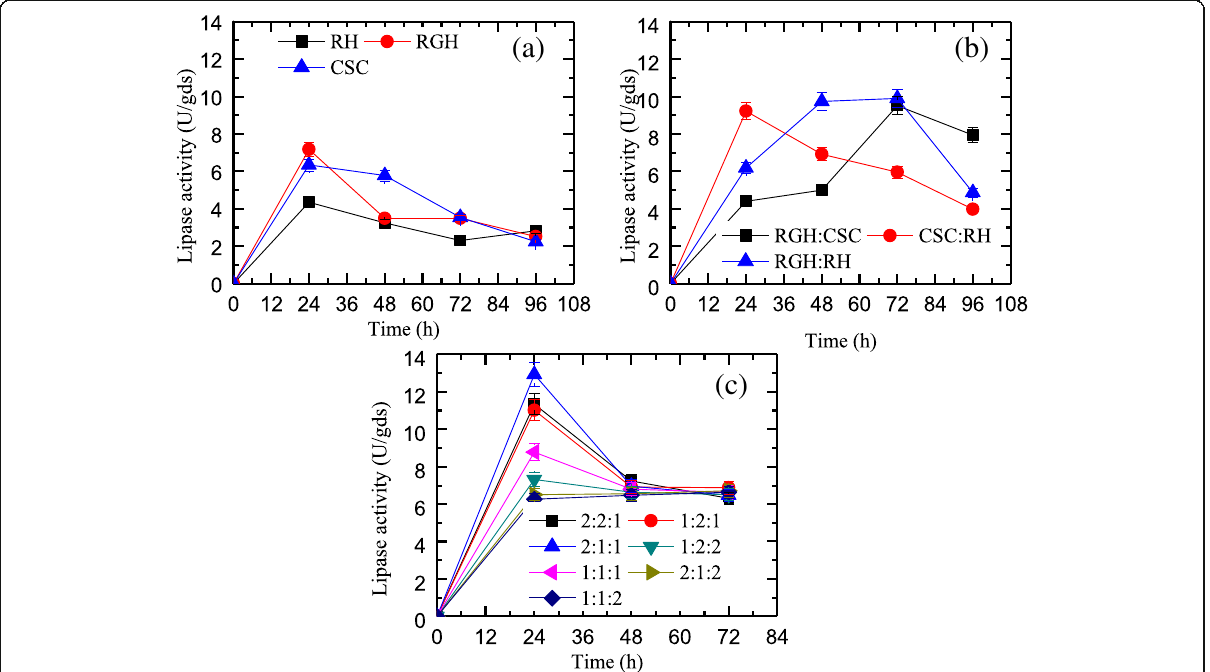
Fig. 2 Lipase activity (U/gds) with different solid substrates (RH, RGH, and CSC) compositions. a Individual substrates. b Mixture of two substrates. c Mixture of three solid